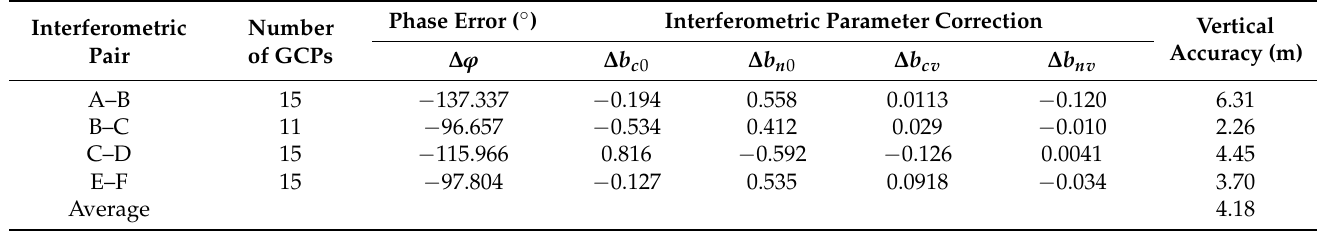
Table 6. Vertical accuracies of the interferometric results after the interferometric calibration process.